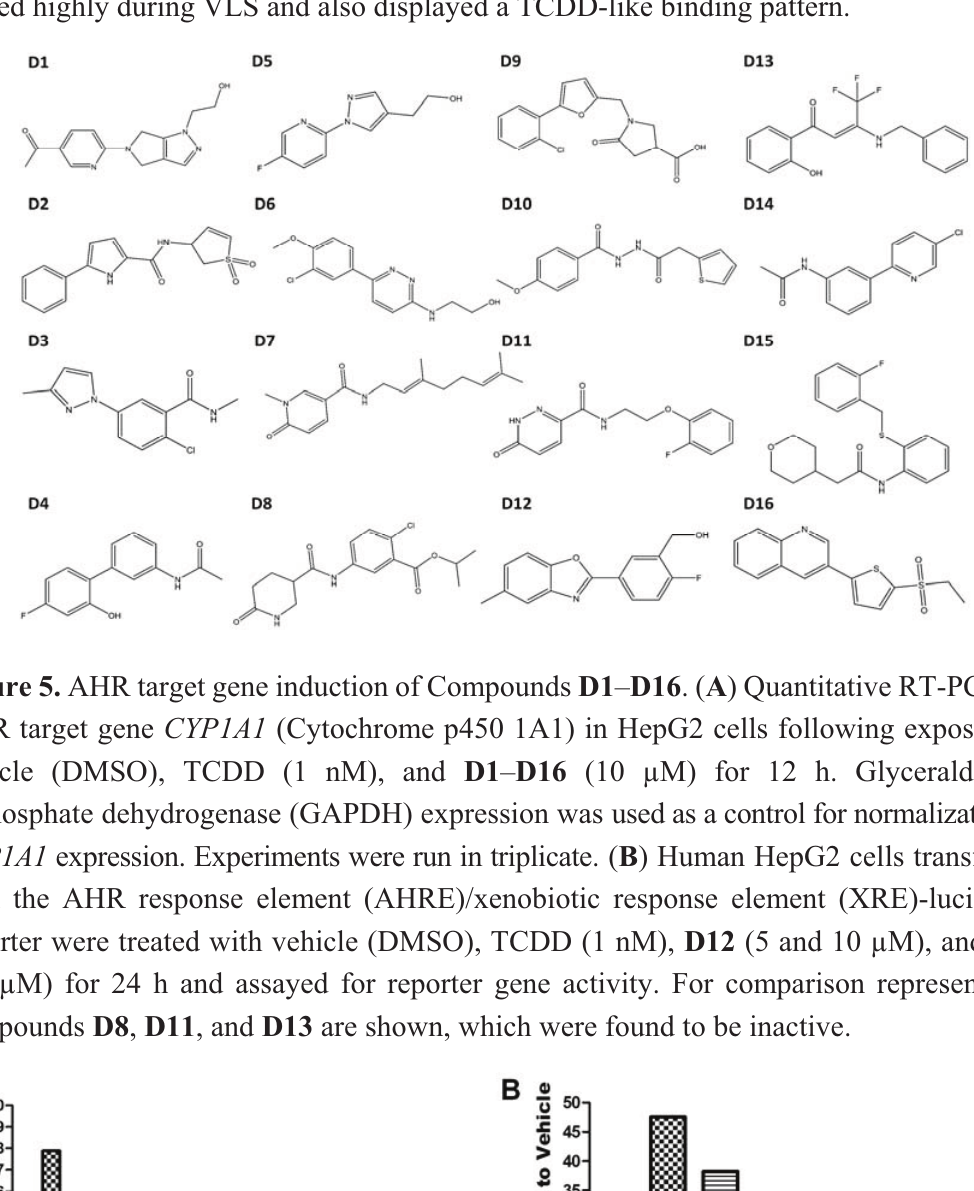
Figure 4. Structures of compounds selected for experimental testing. Compounds D1 – D16 scored highly during VLS and also displayed a TCDD-like binding pattern.